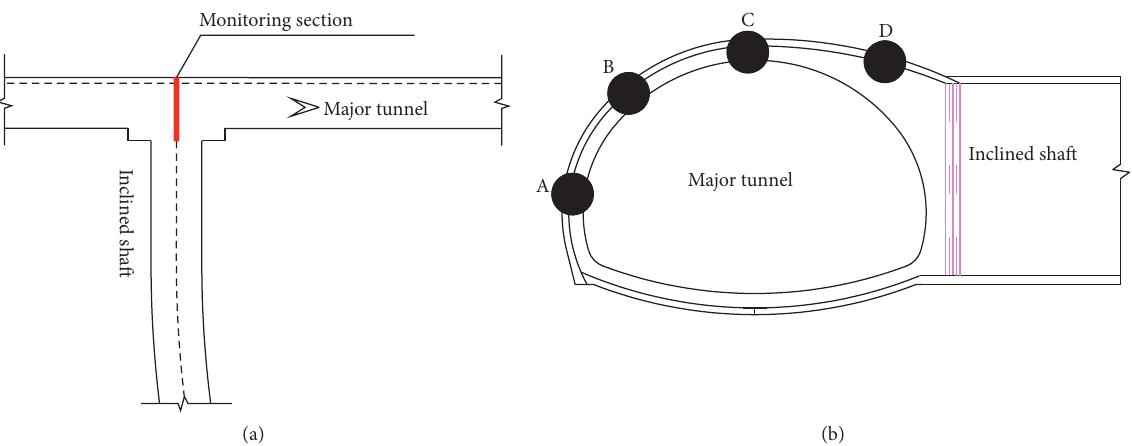
Figure 20: Location of monitoring. (a) Location of monitoring section. (b) Location of monitoring